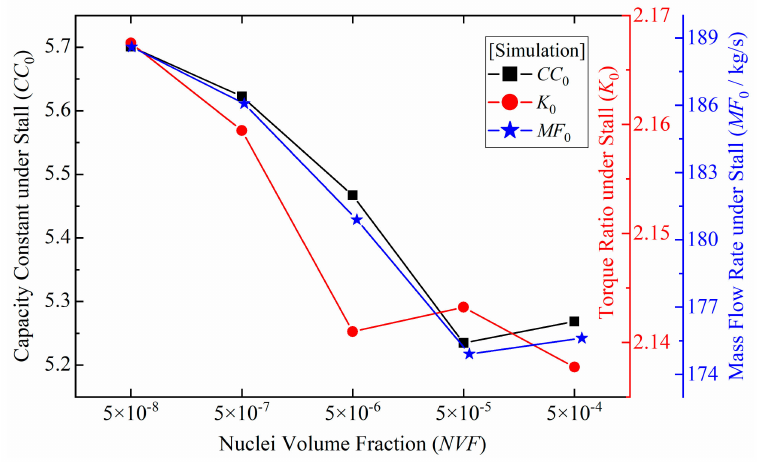
Figure 11. Capacity constant, torque ratio, and mass flow rate of torque converter at stall under various nuclei volume